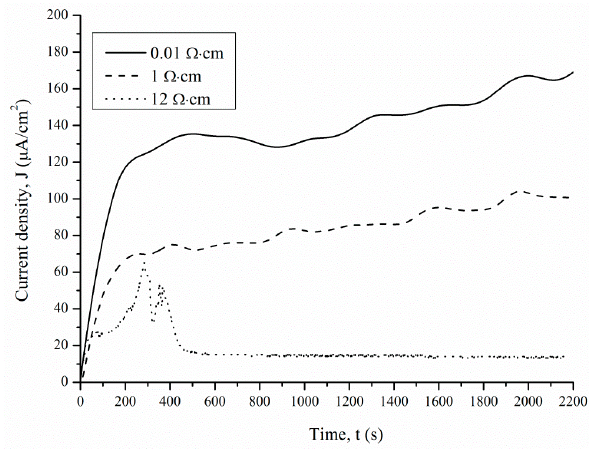
Figure 5. Current density measured in the dark.